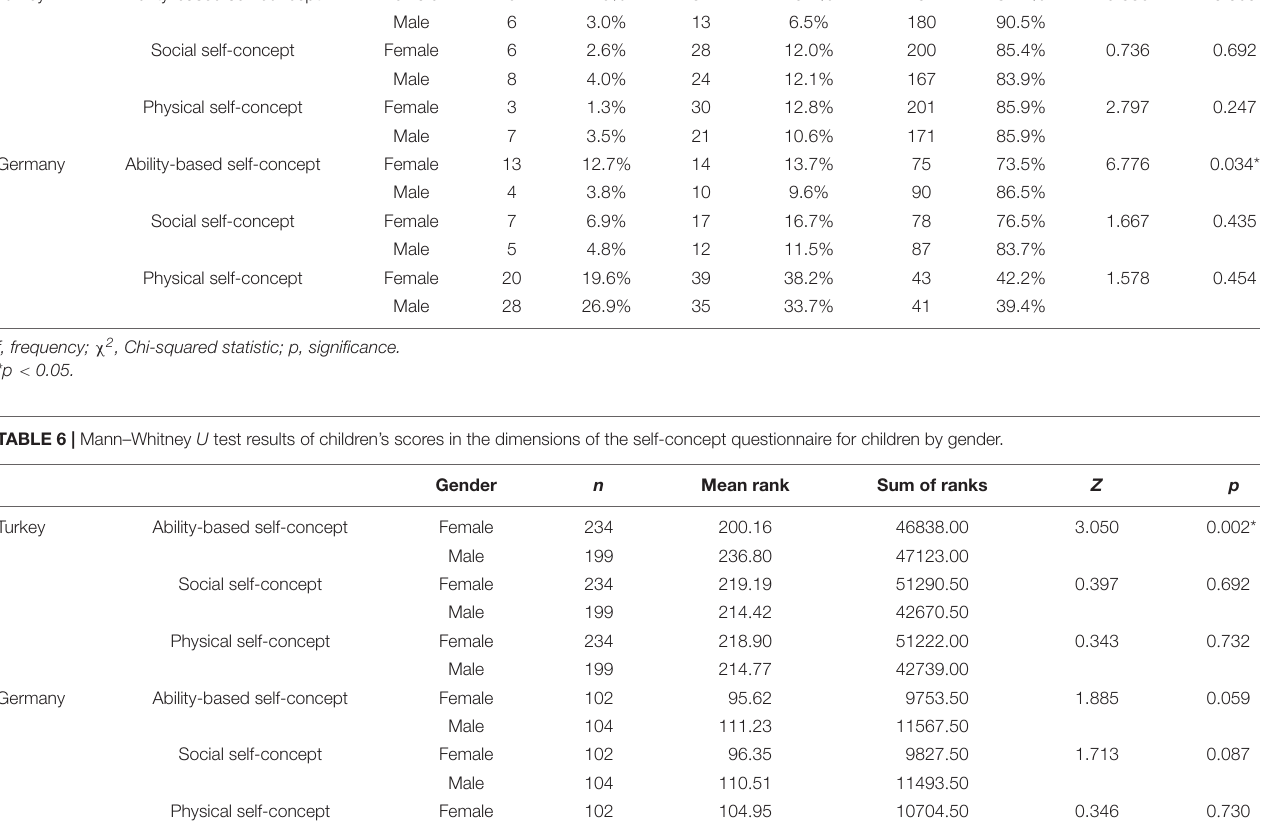
TABLE 5 | Frequency and percentage distribution in the dimensions of the self-concept questionnaire for children by gender. Dimensions Gender Low Risk group Normal χ 2 p f % f % f %